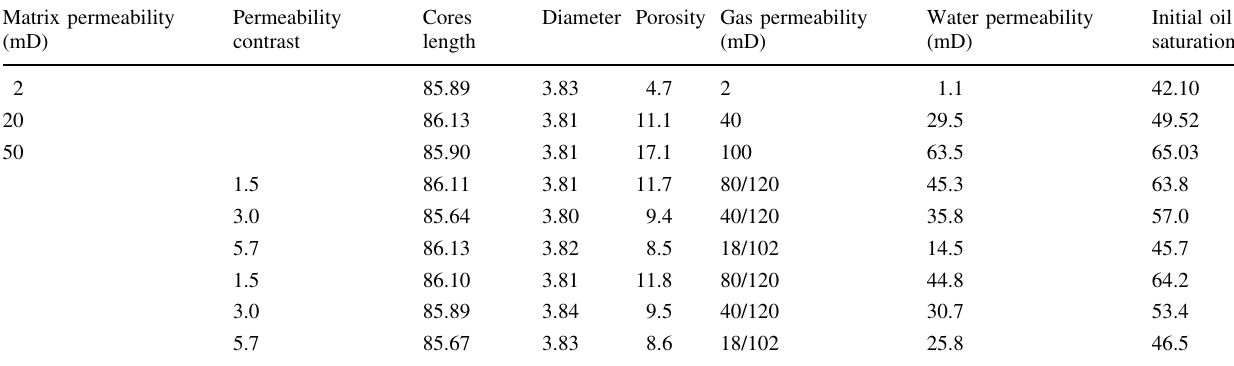
Table 1 Oil properties and synthetic cores basic parameters Matrix permeability